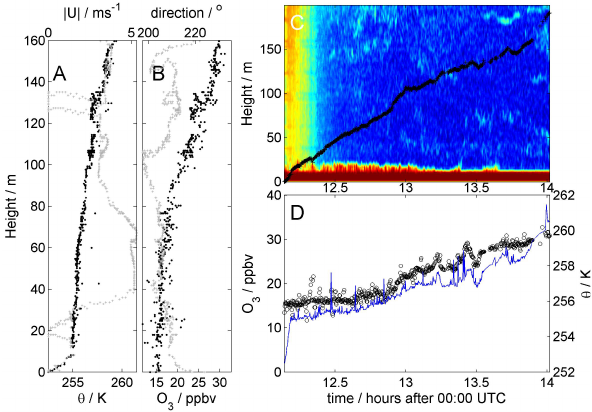
Fig. 4. As for Fig. 3, but for 24 August 2007. Please note the difference in scales.